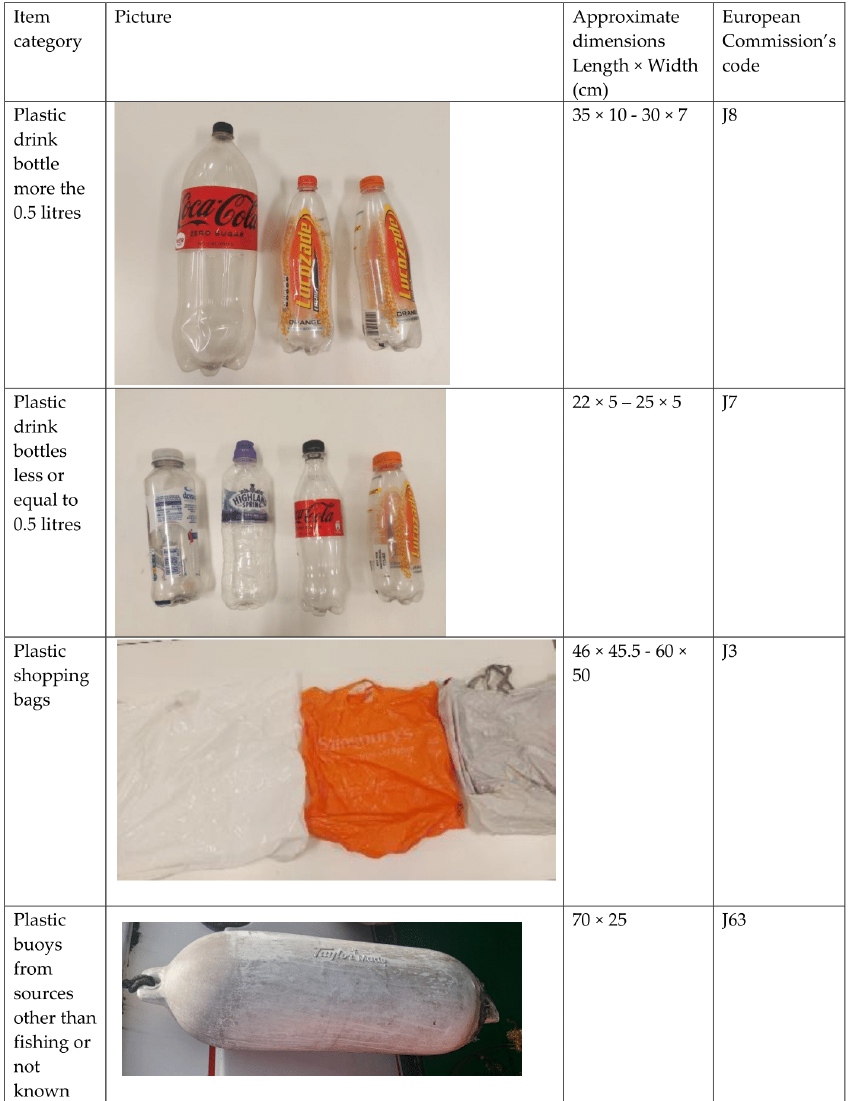
Figure 1. Table displaying objects used for filming, the approximate dimensions for each item and the Commission’s Joint List of Litter Categories for Marine Macrolitter monitoring code for each category